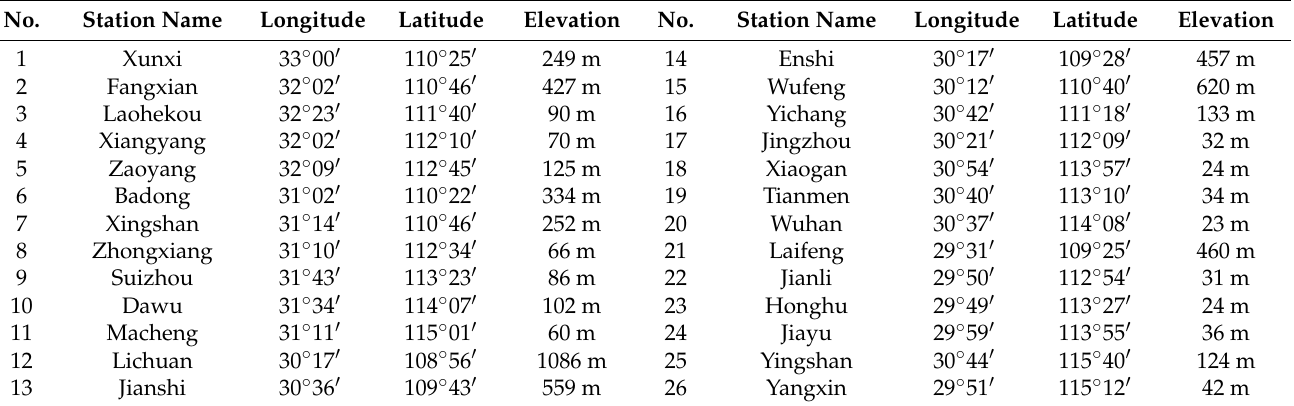
Table 1. Descriptions of the meteorological stations within Hubei